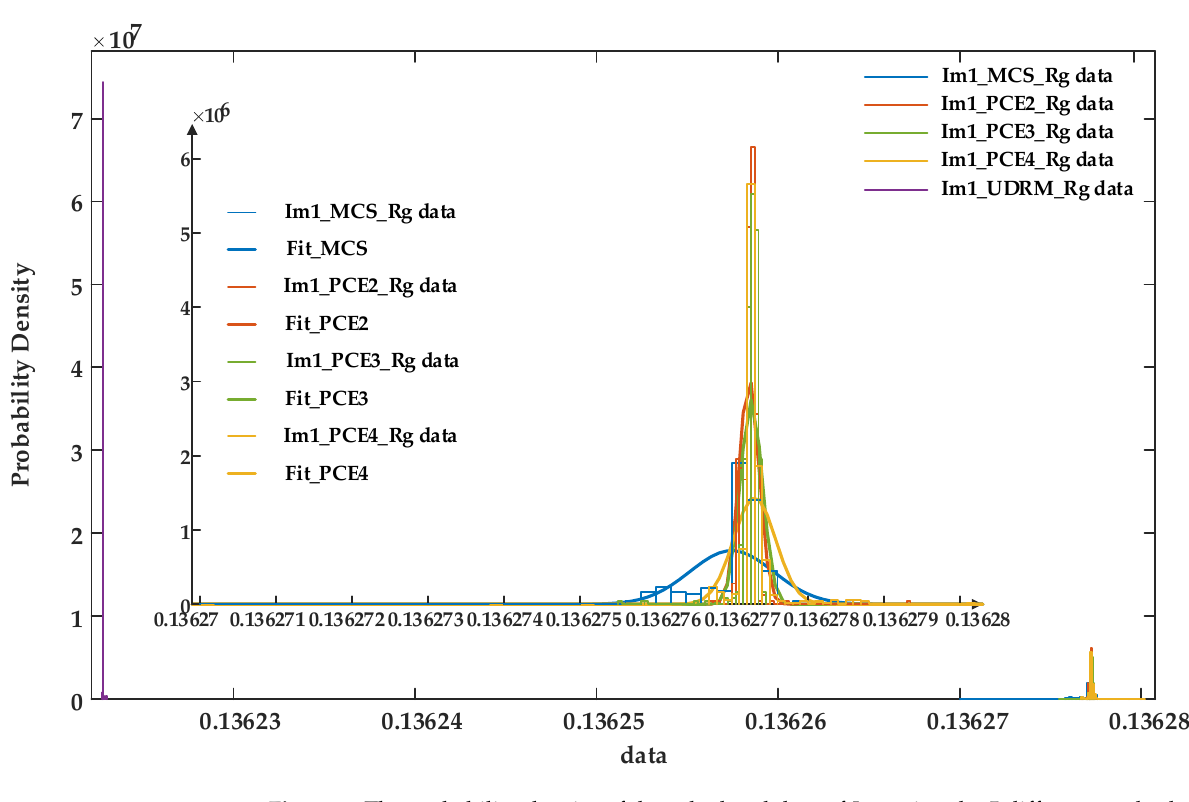
Figure 7. The probability density of the calculated data of I m1 using the 5 different methods under 50% uncertainty of sheath resistivity under normal operation.